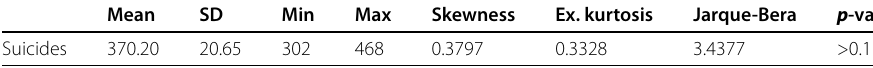
Table 1 Descriptive statistics of data on suicide occurrences